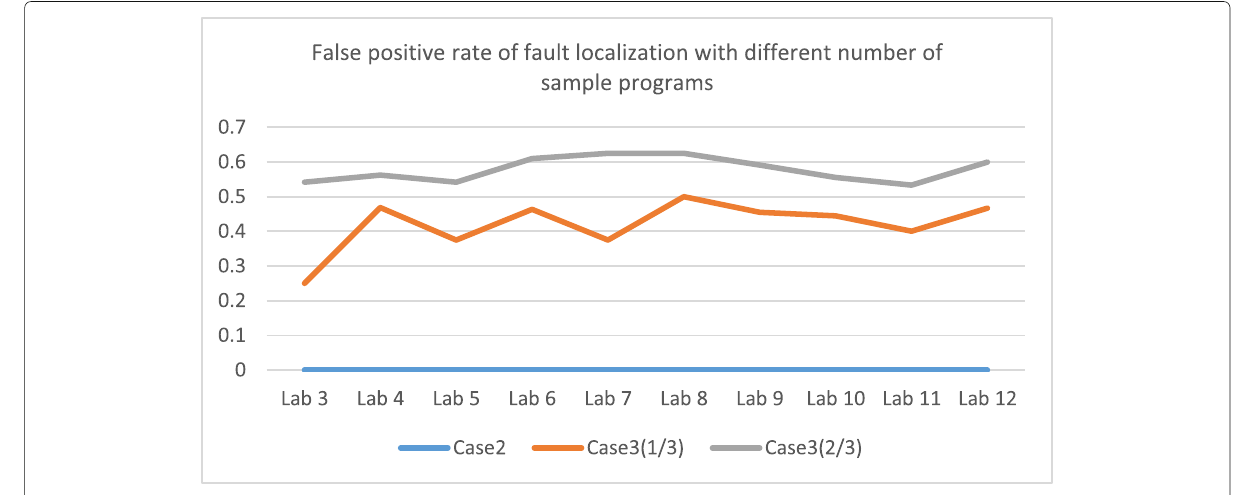
Fig. 5 Number of bugs in programs failed for all the test cases